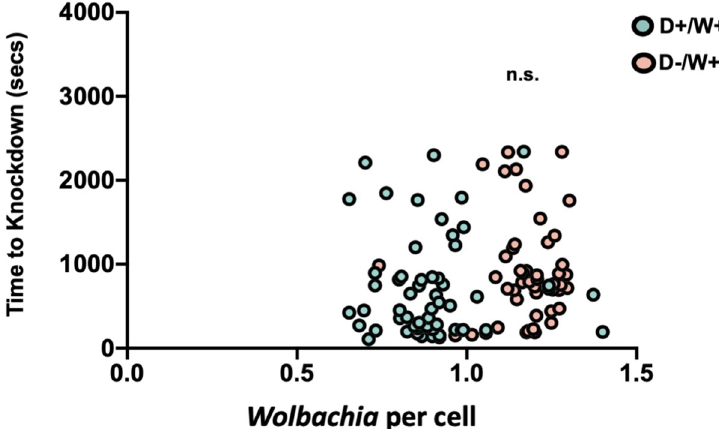
Fig 5. Relationship between bacterial load and time to knockdown in mosquitoes. Each point represents a single mosquito, with individuals from all 4 replicate experiments presented on one graph. There was no significant relationship (Pearson correlation, p < 0.05) between knockdown time and Wolbachia load for the pooled set or for individual replicate experiments analyzed separately (S6 Table). replicates. However, in only one replicate (#5), the DENV effect is greater than the Wolbachia effect (D+W- vs D-W+), increasing KD time. This pattern of DENV potentially being stronger than Wolbachia is also in keeping with that Wolbachia was significant in 5/6 ANOVAs com- pared to 6/6 for DENV (S4 Table).